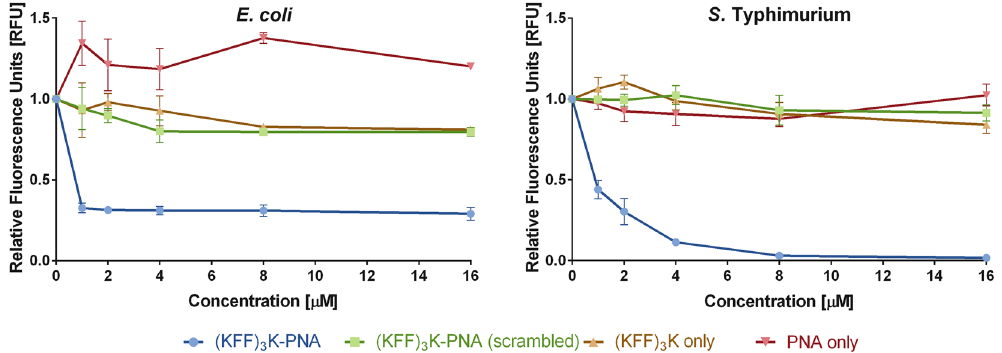
Figure 4. Inhibition of RFP synthesis after treating cells with (KFF) 3 K-PNA, (KFF) 3 K-PNA (scrambled), PNA anti-m rfp1 or free (KFF) 3 K. For the sequence of the PNA targeted at the mRNA transcript encoding RFP, see Fig. 2. The mean values from three independent experiments are plotted, with error bars indicating the standard error. The fluorescence intensity given in relative fluorescence units [RFU] correlates well with the cellular RFP level (see Methods). Data for all tested concentrations are shown in Table S1. The differences between RFU obtained for (KFF) 3 K-PNA and each of the other compounds are highly significant with P ≤